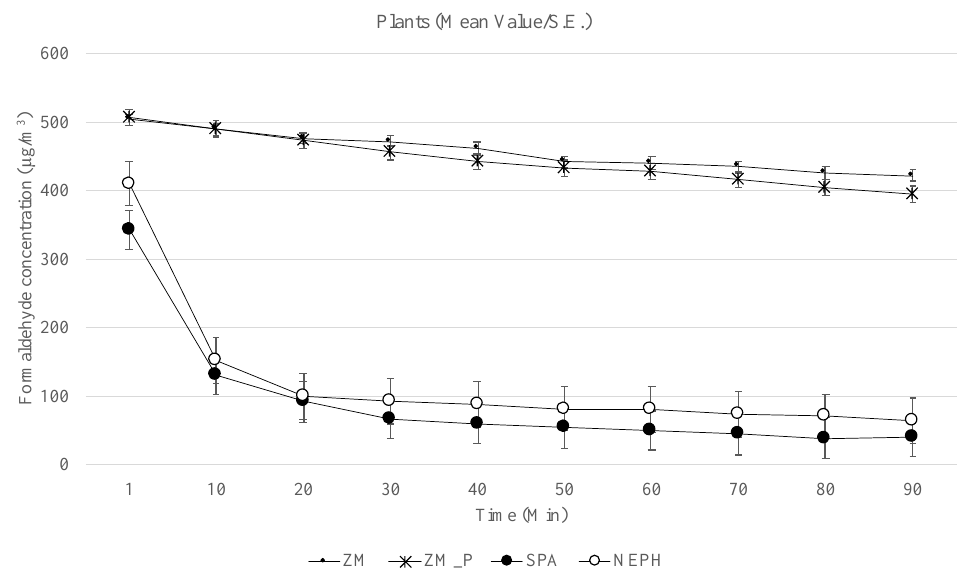
Figure 7. Measured formaldehyde concentration (( µ g/m 3 )/h) when plant samples were tested: zero measurement (ZM), zero measurement with the plastic pot (ZM_P), peace lily (SPA), Boston fern (NEPH). Data means ± SE, n = 3. Plants (Mean Value/S.E.)